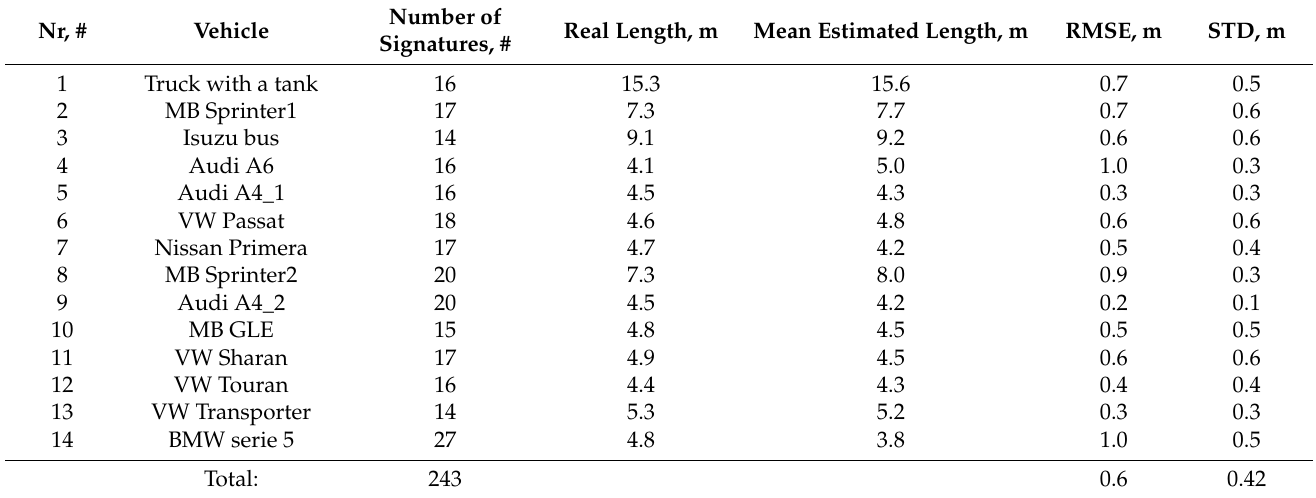
Table 1. Length estimation method result with the second